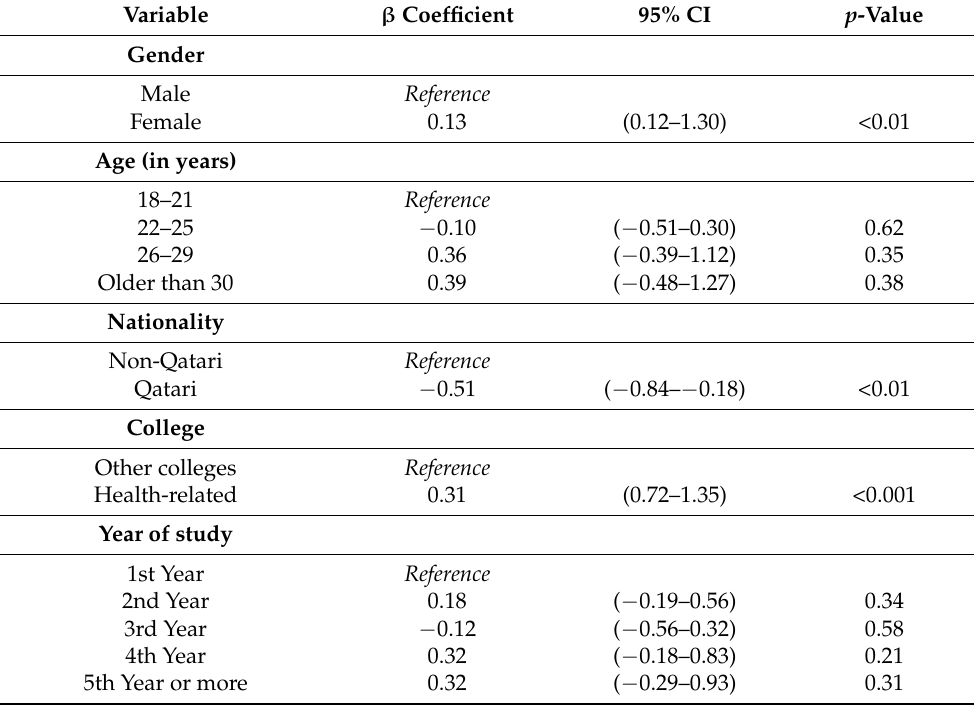
Table 3. Factors associated with PMS knowledge score (multivariable regression